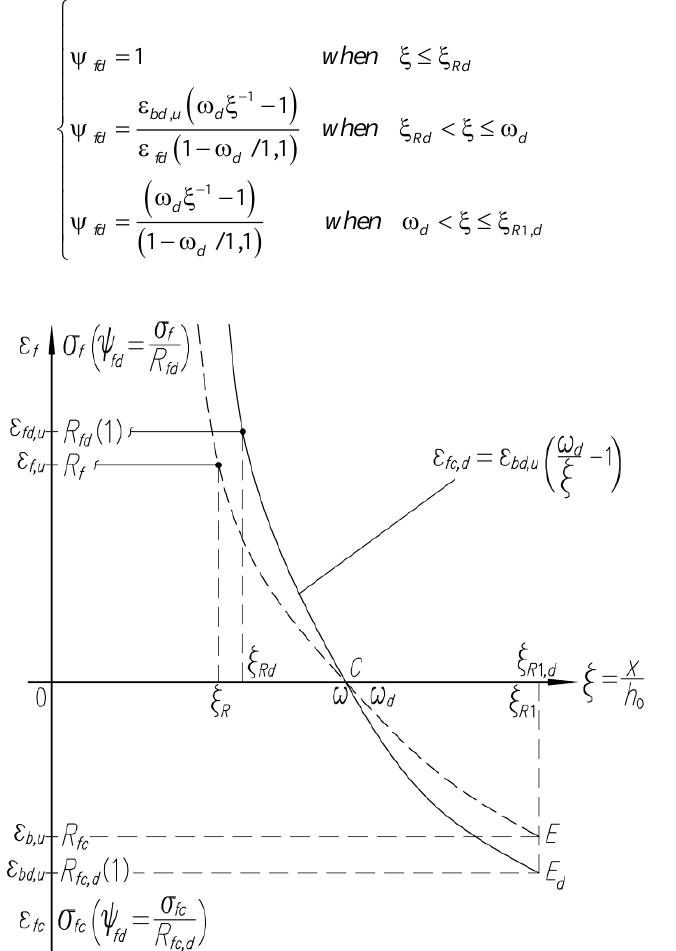
Fig. 2. Relationship between the value of the relative stresses ψ fd in the FRP and the relative height of the compressed zone of the normal section ξ of FFE-elements: with static (dashed line) and short-term dynamic (solid line)